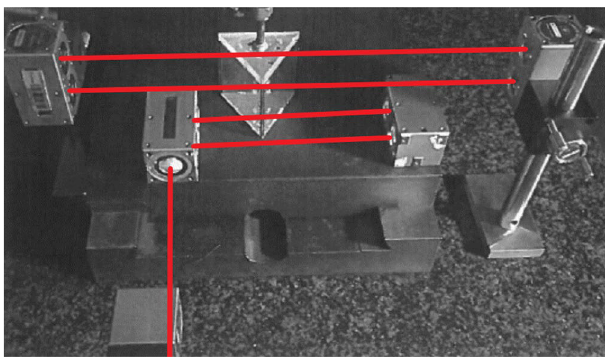
Figure 4. Setup with extra laser beams to continue measuring the zero position.